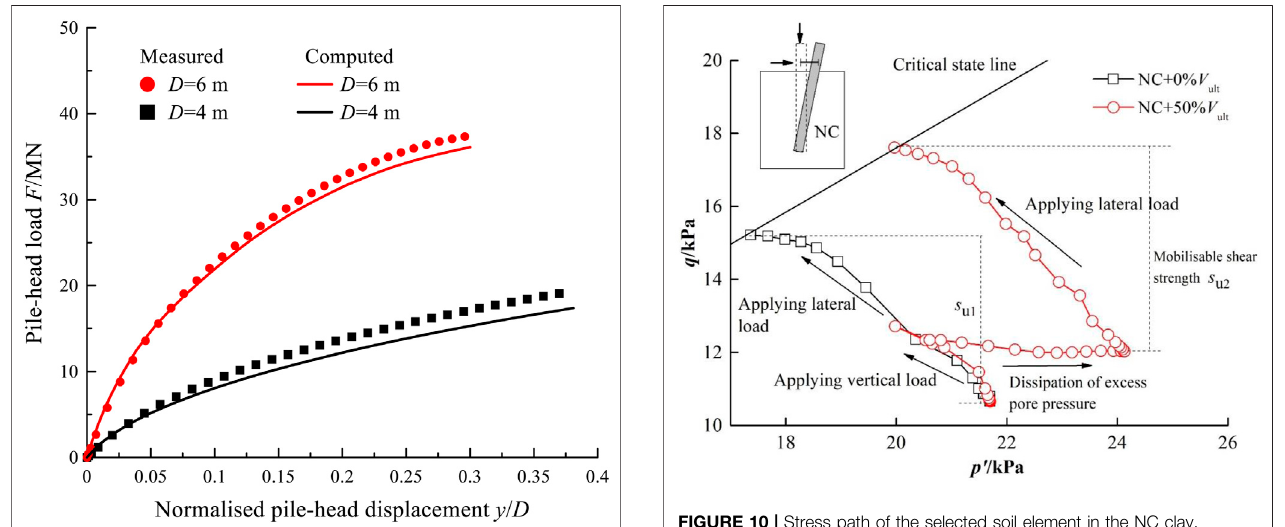
FIGURE 10 | Stress path of the selected soil element in the NC